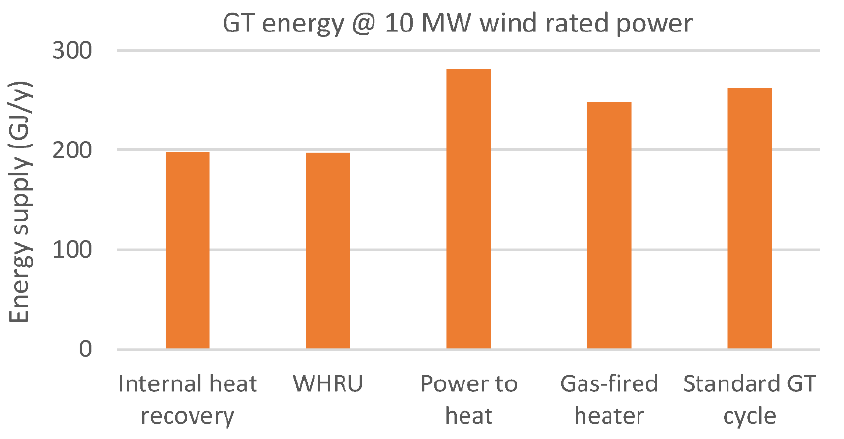
Figure 3. Gas turbine (GT) energy contribution to the total energy demand for the different configu- rations at 10 MW wind rated power.